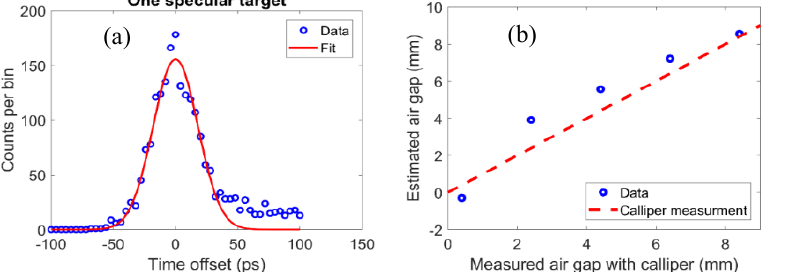
Fig. 1: (a) The measured signal from one specular target. The FWHM of the trace is 42 ps. The measured data is shown as circles and the solid line is a Gaussian fit. (b) Estimated air gap between the two